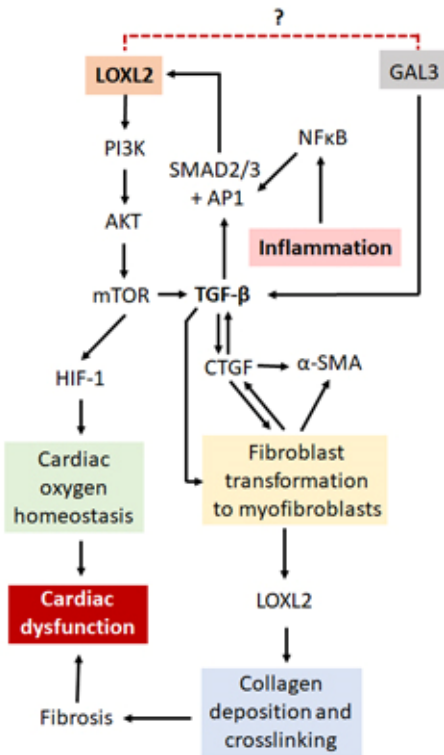
Figure 4. A proposed mechanism by which LOXL2 causes fibrosis and cardiac dysfunction. LOXL2 acts via the PI3K / AKT / mTOR pathway to activate TGF- β signaling and HIF-1 protein expression. GAL3 also activates TGF- β signaling, thus with possible similar e ff ects as LOXL2. TGF- β signaling results in an increase in α -SMA, CTGF and LOXL2 expression, which leads to an increase in collagen deposition and cross-linking, resulting in fibrosis, ventricular sti ff ness and cardiac dysfunction. Inflammation causes an increase in NF κ B which interacts with AP1 and Sp-1 proteins, also increasing LOXL2 expression. Dysregulation of HIF-1 protein expression results in the disruption of oxygen homeostasis in the heart, also having pathological e ff ects. Further investigation is needed to find out whether there is a direct interaction between LOXL2 and